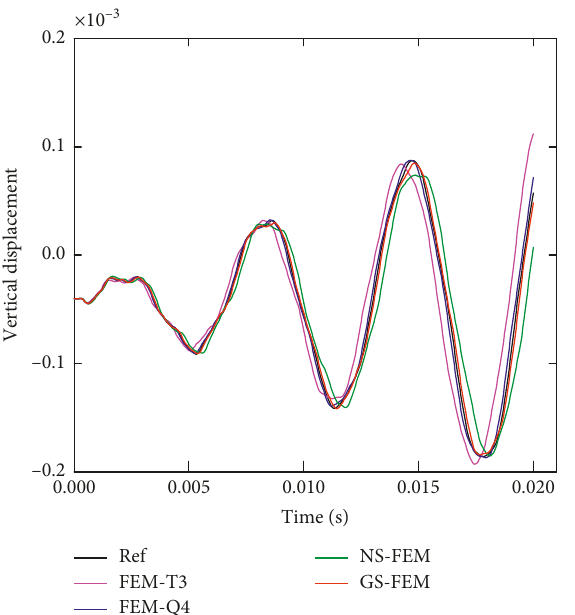
Figure 37: Transient response of point